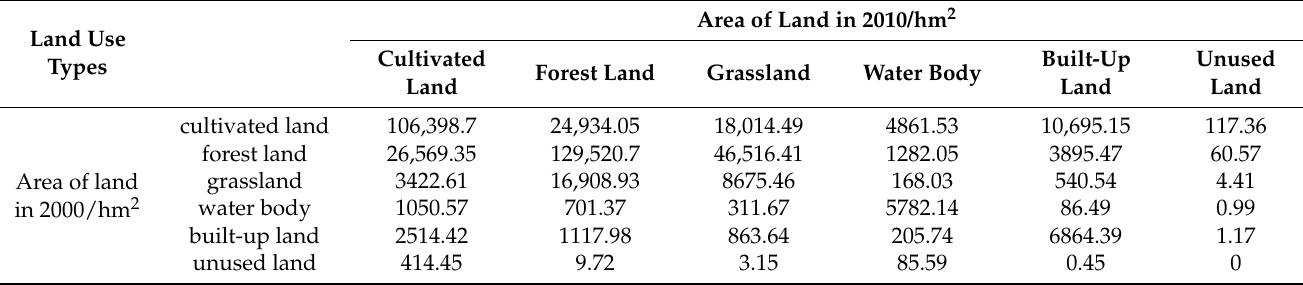
Table 2. Land use transfer matrix from 2000 to 2010 (hm 2